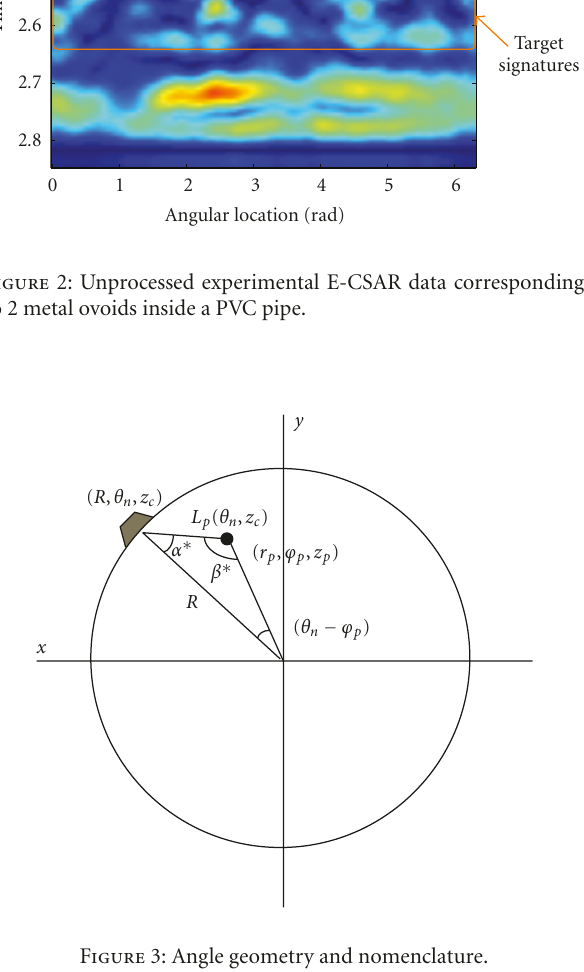
Figure 3: Angle geometry and